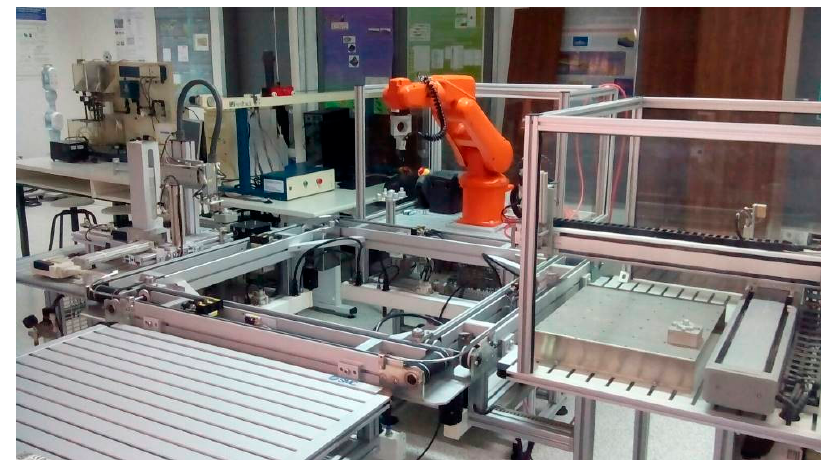
Figure 8. Stations of the FMS in the laboratory.